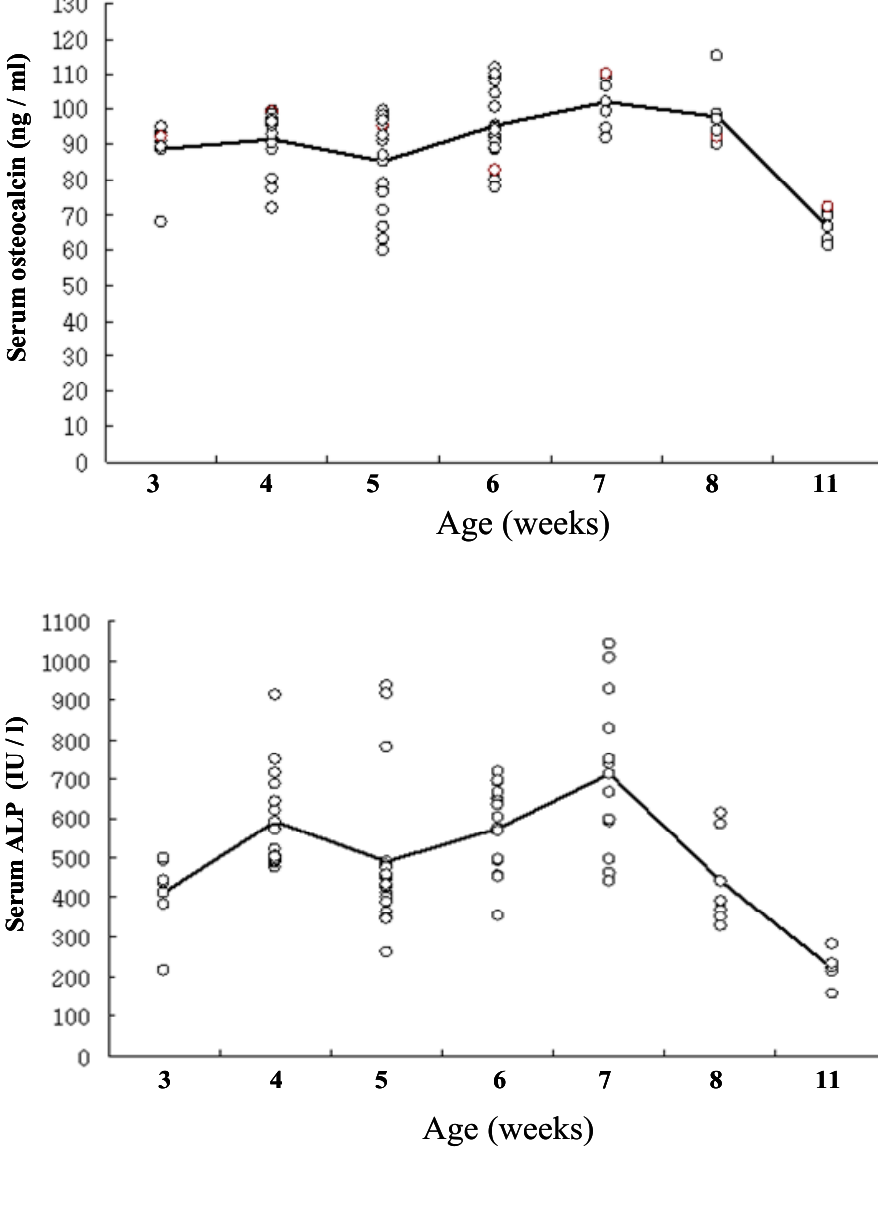
Figure 1. Changes of osteocalcin content (upper panel) and bone-specific alkaline phosphatase activity (lower panel) in serum of Sprague-Dawley rats by age groups. Mean of measurement values indicated on the